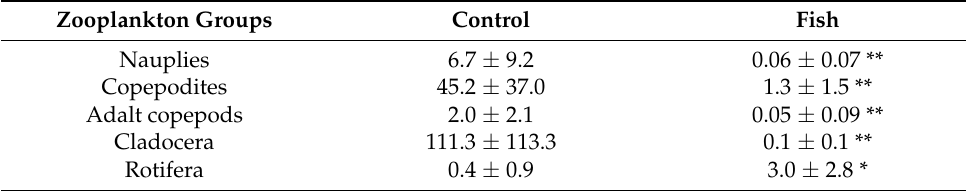
Table 1. The densities (ind./L ± SD) of different zooplankton groups in the control and fish treatments at the end of the experiment. Zooplankton Groups Control Fish Nauplies 6.7 ± 9.2 Copepodites 45.2 ± 37.0 Adalt copepods 2.0 ± 2.1 Cladocera 111.3 ± 113.3 0.1 ± 0.1 ** Rotifera 0.4 ± 0.9 3.0 ± 2.8